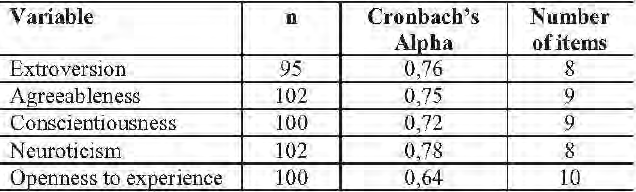
Table 1: Internal consistency reliability of scales